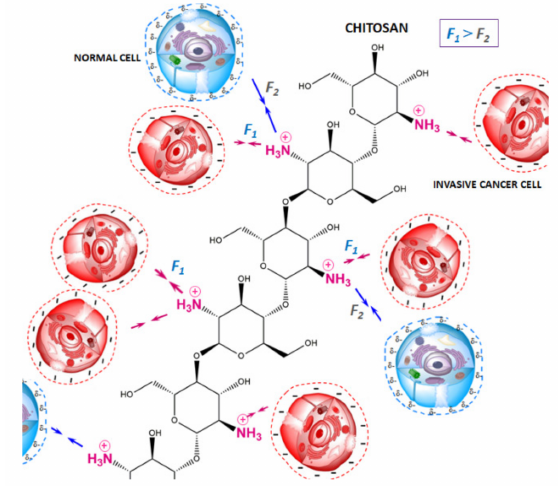
Figure 7. Possible electrostatic mechanism for the screening of invasive cancer cells and their differentiation from normal cells using chitosan-based microparticles. F1 represents the strength of cancer cell–chitosan particle interactions. F2 represents the strength of interactions between normal cells and chitosan